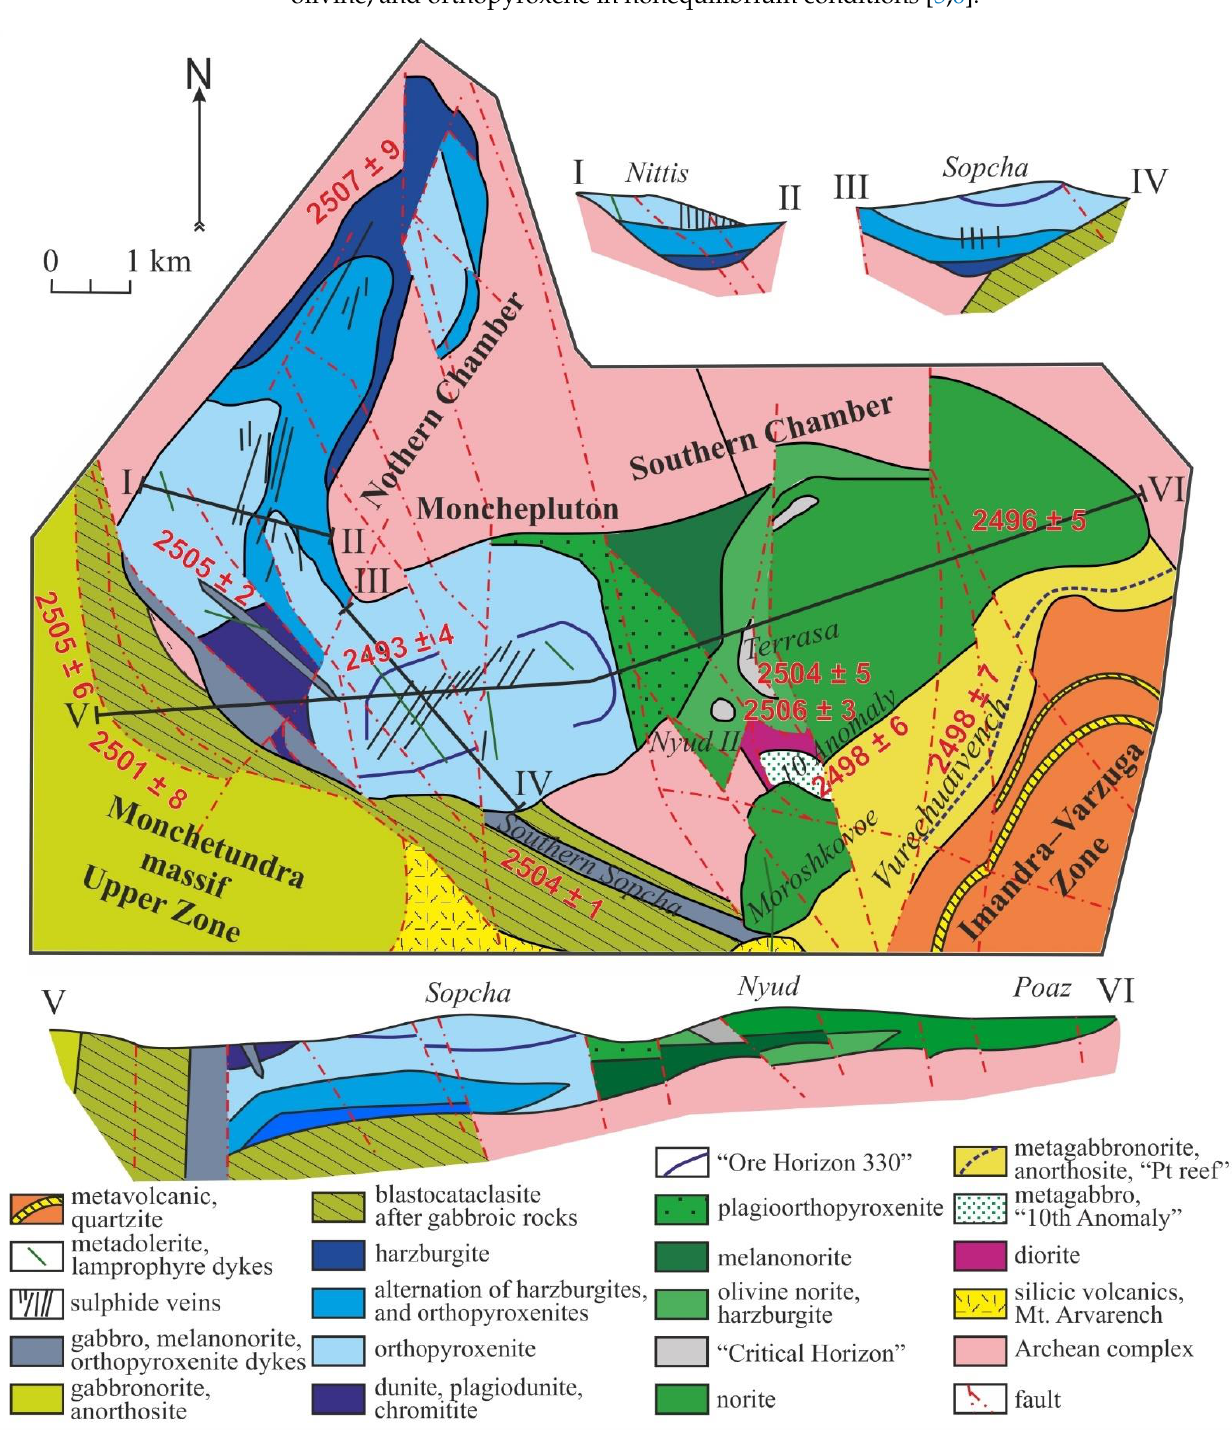
Figure 2. Geological map of the Monchepluton, related geological sections, and U – Pb age (Ma) of igneous rocks, modified after [5].